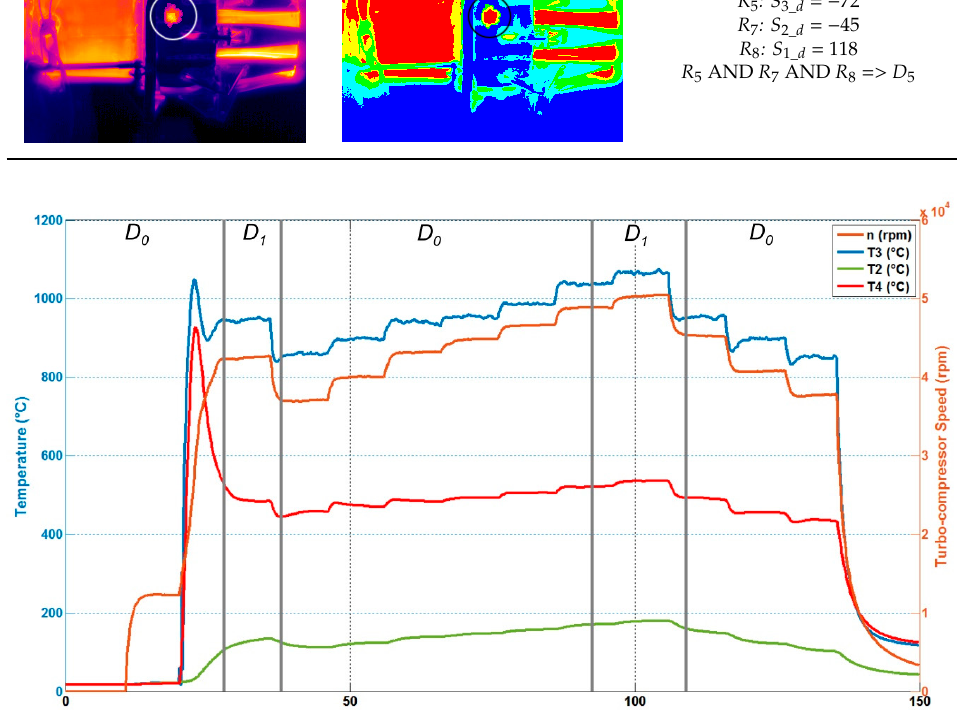
Figure 20. The division of the engine’s operation into technical states D 0 and D 1 .